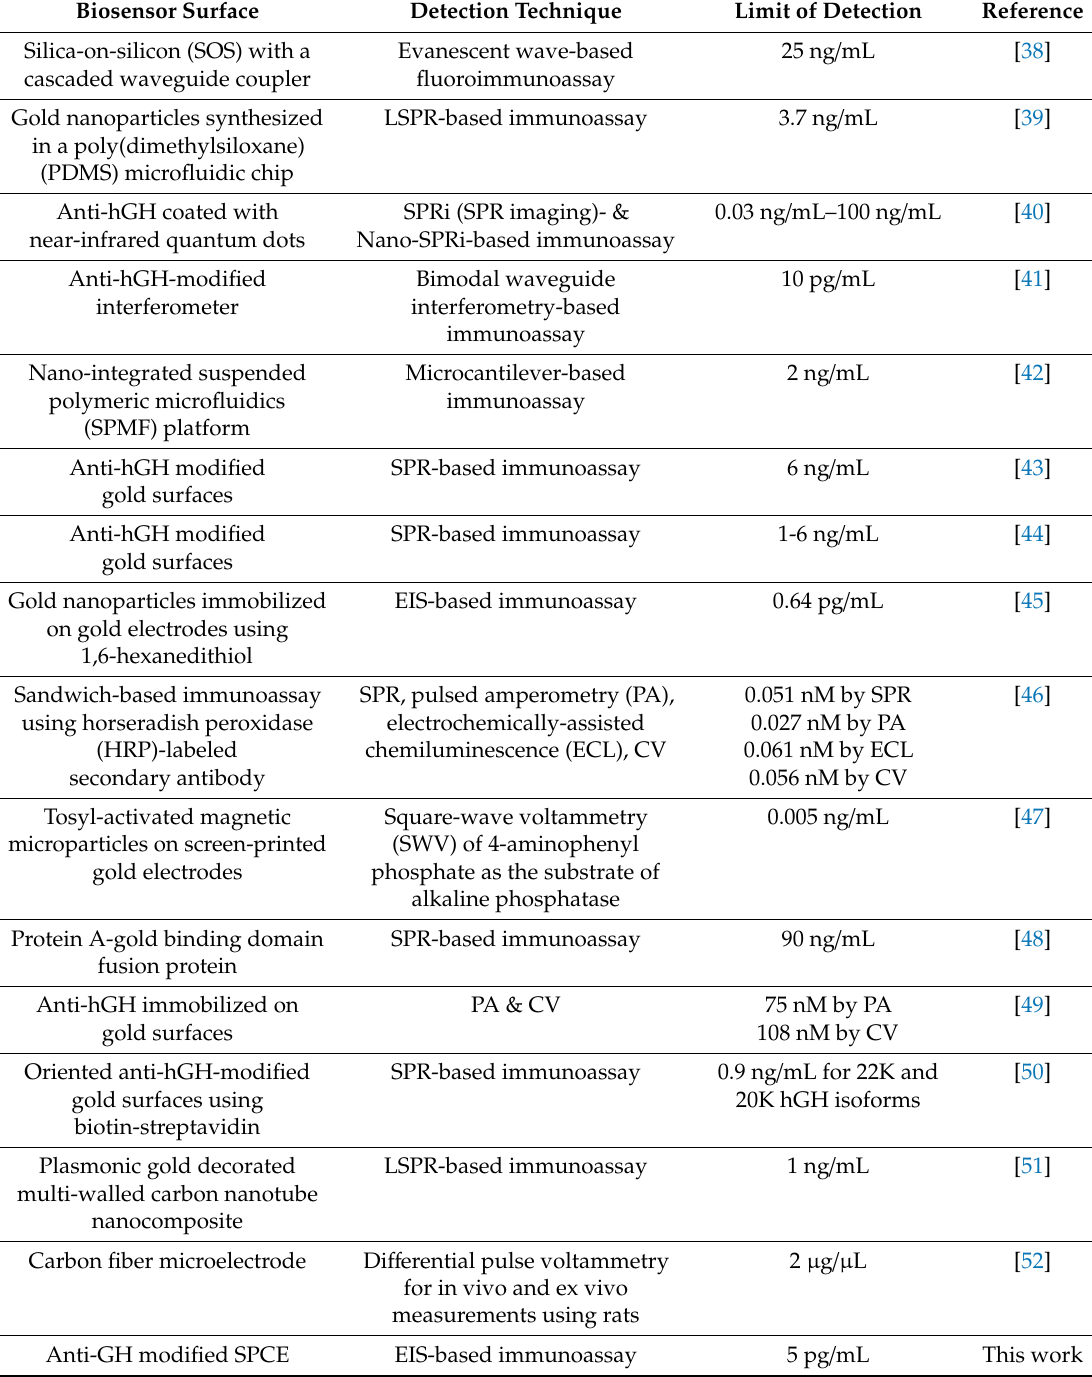
Table 1. A summary of published literature on the detection of GH using biosensors with optical and electrochemical detection